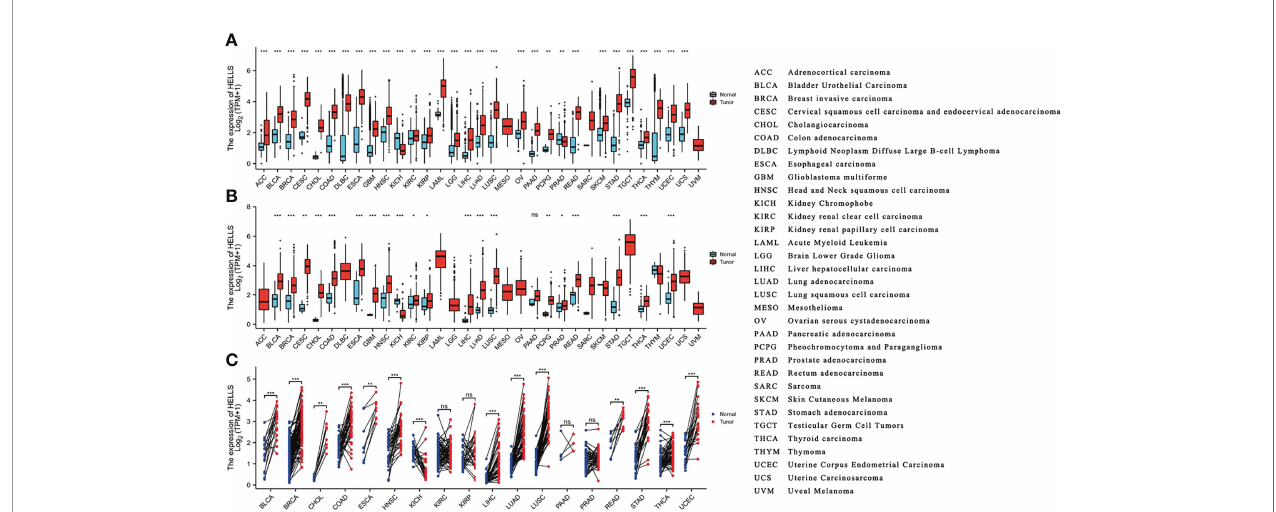
FIGURE 2 | The expression of HELLS mRNA in pan-cancer. (A) Expression of HELLS between the 33 cancers and normal tissues in unpaired sample analysis; (B) Expression of HELLS between the 33 cancers and paracancerous tissues in unpaired sample analysis; (C) Paired sample analysis of HELLS mRNA expression between 18 cancers and paracancerous tissues in BLCA, BRCA, CHOL, COAD, ESCA, HNSC, KICH, KIRC, KIRP, LIHC, LUAD, LUSC, PAAD, PRAD, READ, STAD, THCA and UCEC. ∗ p < 0:05, ∗∗ p < 0:01, ∗∗∗ p < 0:001. ns, Not Signi fi